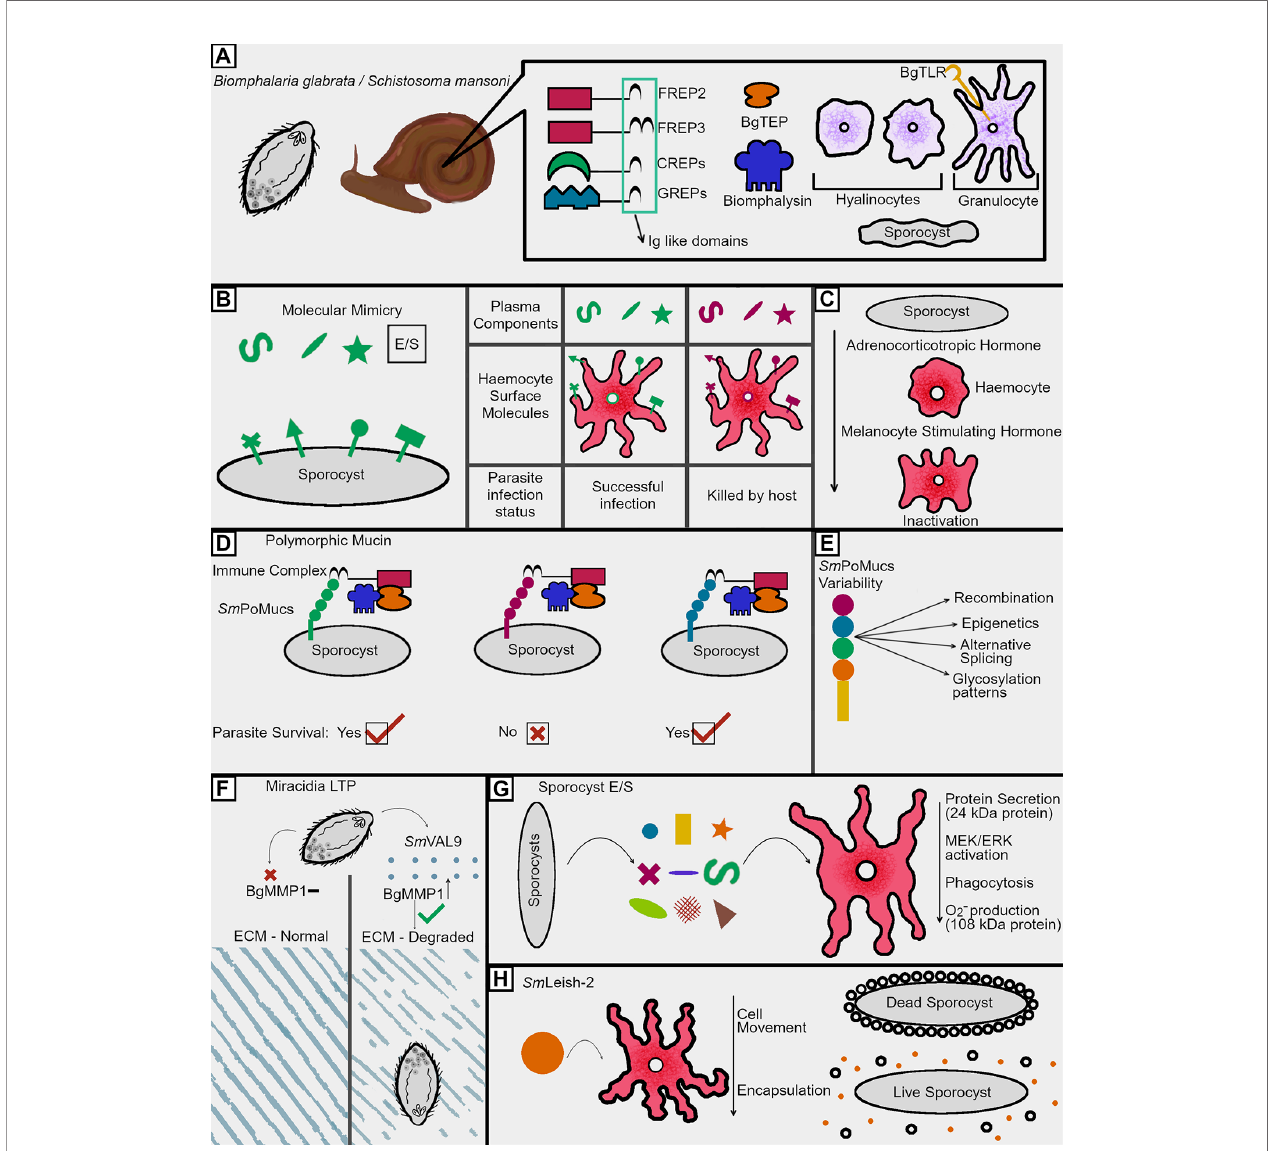
FIGURE 1 | Immunosuppression tactics in the intermediate host. (A) Snails employ a wide variety of both humoral and cellular factors in combatting schistosome infections, many of which incorporate with each other to facilitate parasite killing. The humoral factors are largely composed of PRRs but also feature cytotoxic components such as biomphalysin. The cellular arm of the immune response features Bg TLR displaying granulocytes, which envelope invading schistosomes, and hyalinocytes, which seemingly focus on the production of humoral factors and cell signaling molecules. (B) Parasites employ molecular mimicry by utilizing surface molecules and E/S products which share glycosylation patterns seen in snail plasma and on the surface of circulating hemocytes. Sharing such glycosylation patterns has been shown to correlate with survival during infection, suggesting these shared epitopes help schistosomes avoid recognition within the snail. (C) Molecular mimicry is also employed by the production of immune cell inactivating hormones like those produced by the snail which renders normally lethal hemocytes inactive and unable to kill invading sporocysts. (D) In order to avoid recognition by host pattern recognition receptors, schistosomes employ a highly variable series of polymorphic mucins. These mucins are recognized by host Bg FREPs, and the variable nature of both the mucins and FREPs has led to the understanding that successful recognition of Sm PoMucs by FREPs is a key determinant of infection success. If the host FREP can recognize the Sm PoMucs and the surface of a sporocyst, that sporocyst will likely be killed, while having an unrecognizable Sm PoMuc leads to immune evasion by avoiding Bg FREP recognition. Such killing is thought to be at least partially dependent on a humoral Bg FREP/ Bg TEP/Biomphalysin complex. (E) In order to generate a highly variable surface mucin, numerous processes occur to give rise to the considerable amount of variability seen between different sporocyst Sm PoMucs. (F) Miracidia employ a venom allergen like protein which has been shown to upregulate the production of a B. glabrata matrix metalloproteinase ( Bg MMP1). This metalloproteinase is hypothesized to facilitate degradation of host connective tissues. Such degradation would allow for easier movement further into the host during initial infection. (G) E/S products from developing sporocysts facilitate the downregulation of key anti-parasitic functions in hemocytes. While some of these proteins have been identi fi ed, others remain of an unknown composition and are merely referred to by their size. (H) SmLeish-2 released by the parasite reduces hemocyte motility and therefore downregulates parasite encapsulation. This allows for continued movement and development of the sporocyst within the